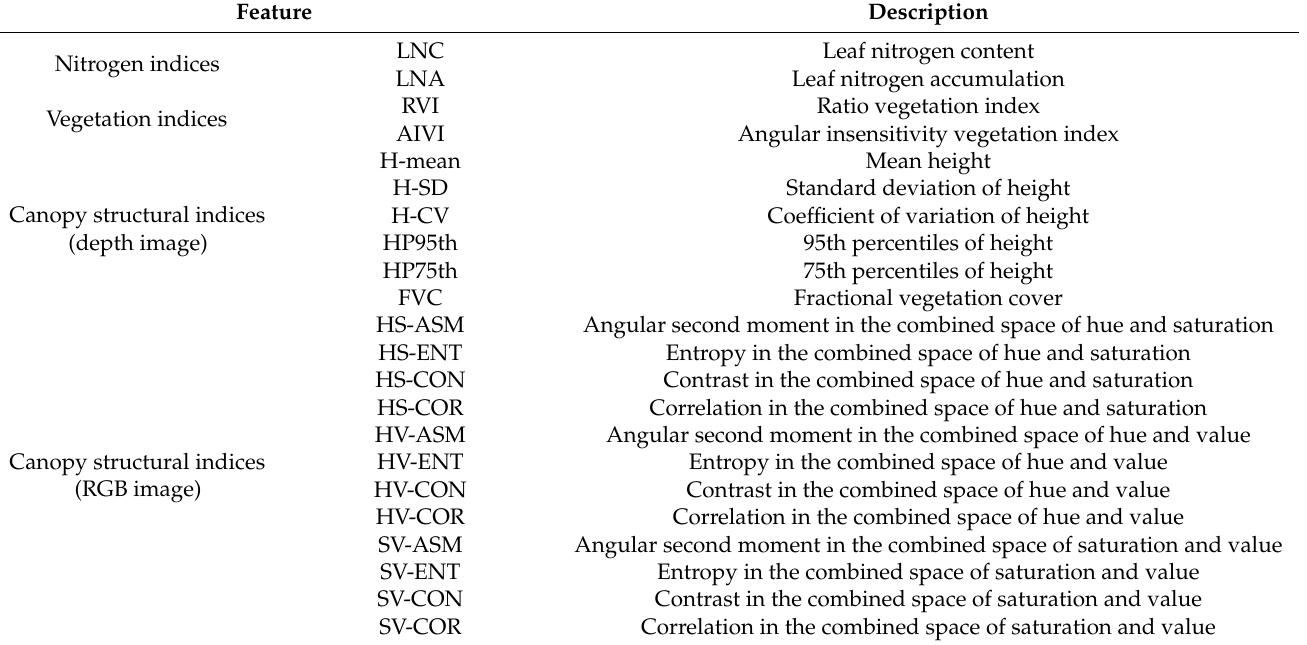
Table 1. Nitrogen indices, vegetation indices and canopy structural indices obtained in this